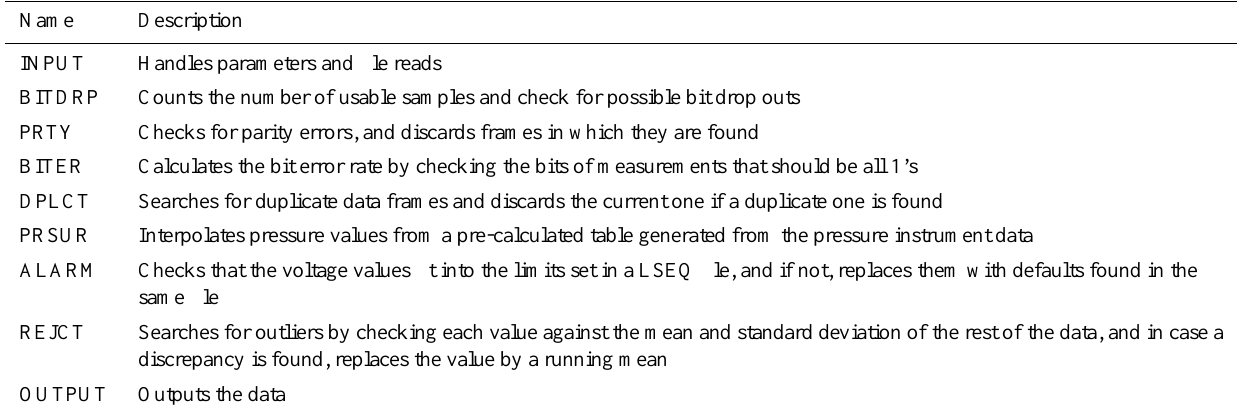
Table 3. Bit error and outlier detection (FEP).